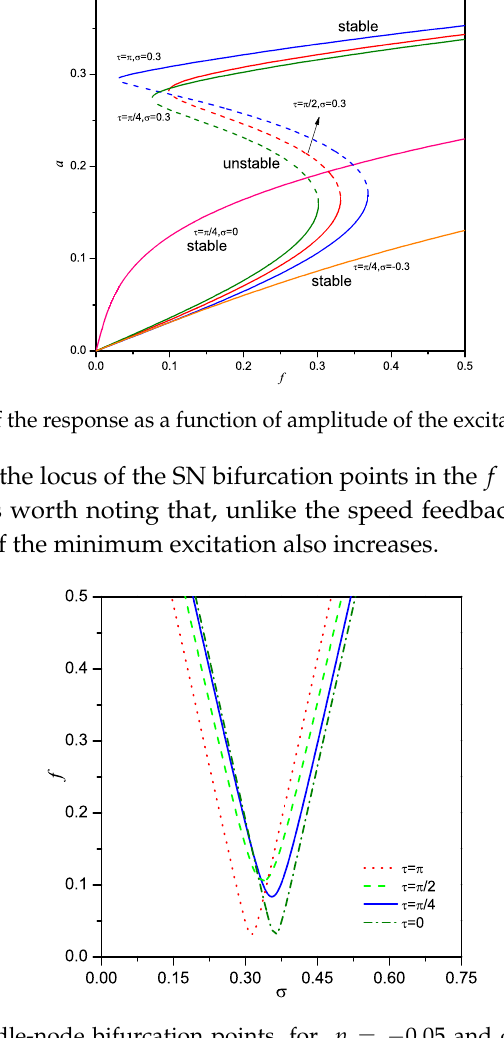
Figure 14. Loci of saddle-node bifurcation points, for p = − 0.05 and different values of τ with acceleration